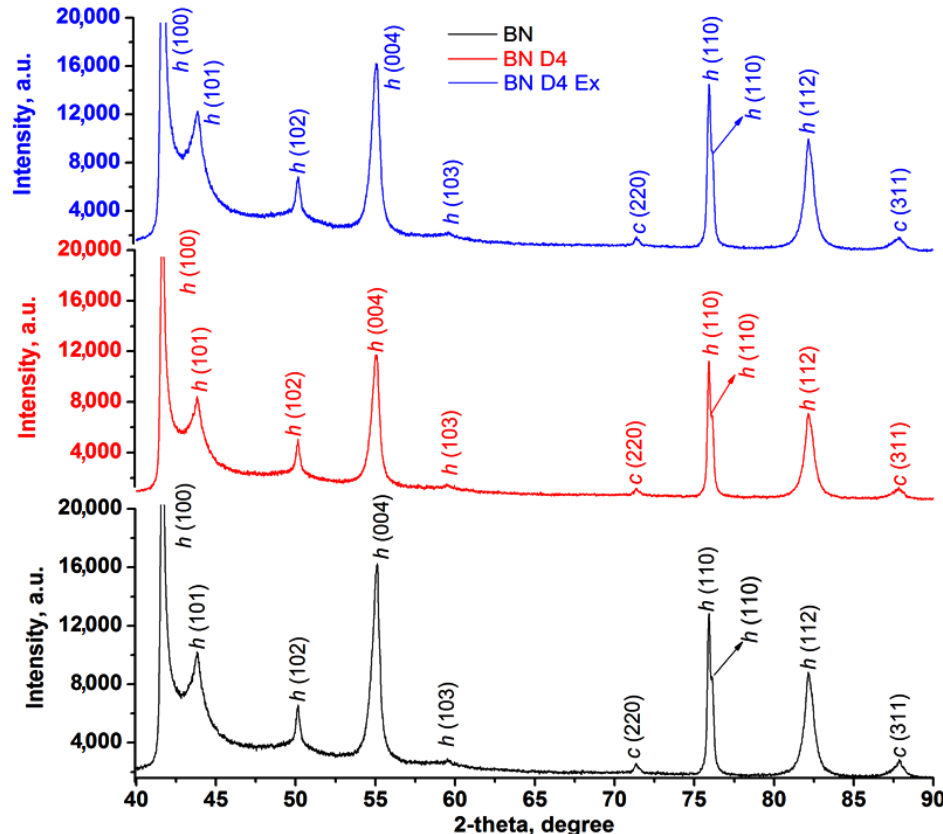
Figure 6. XRD patterns for initial, hydrophobized, and exfoliated BN particles.